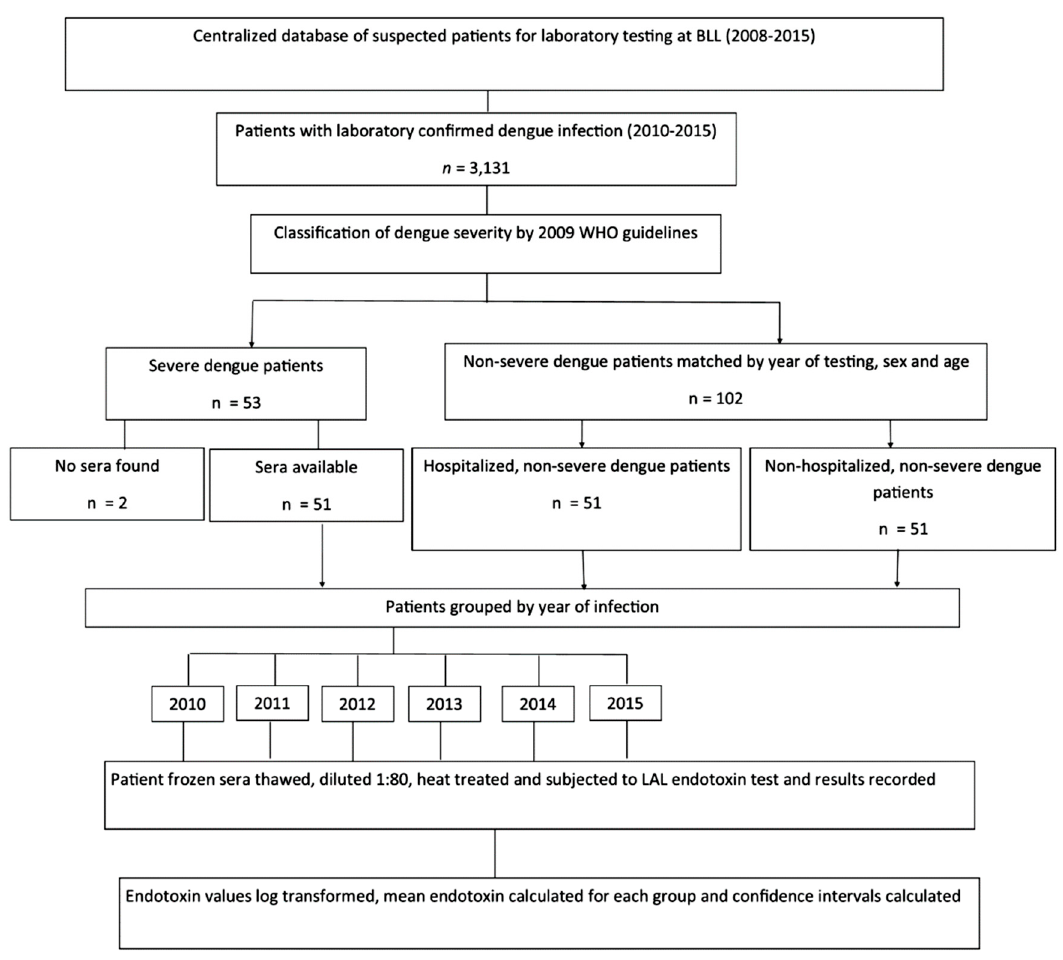
Figure 2. Investigation of serum endotoxin and dengue disease severity method flowchart.